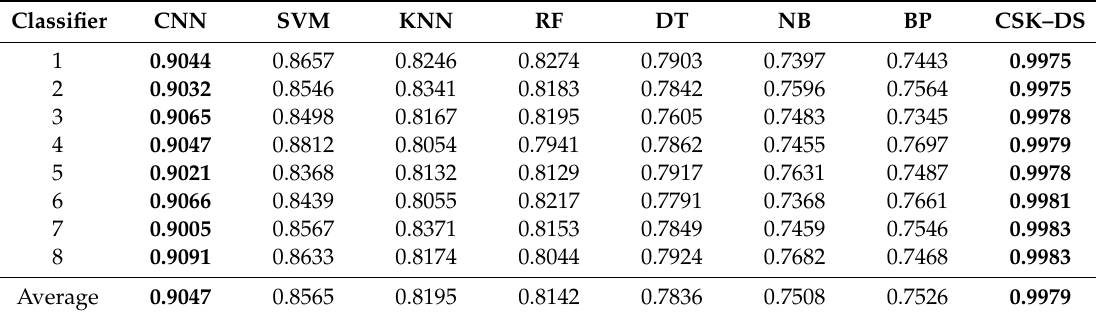
Table 4. Classification rates of test data with the Gaussian